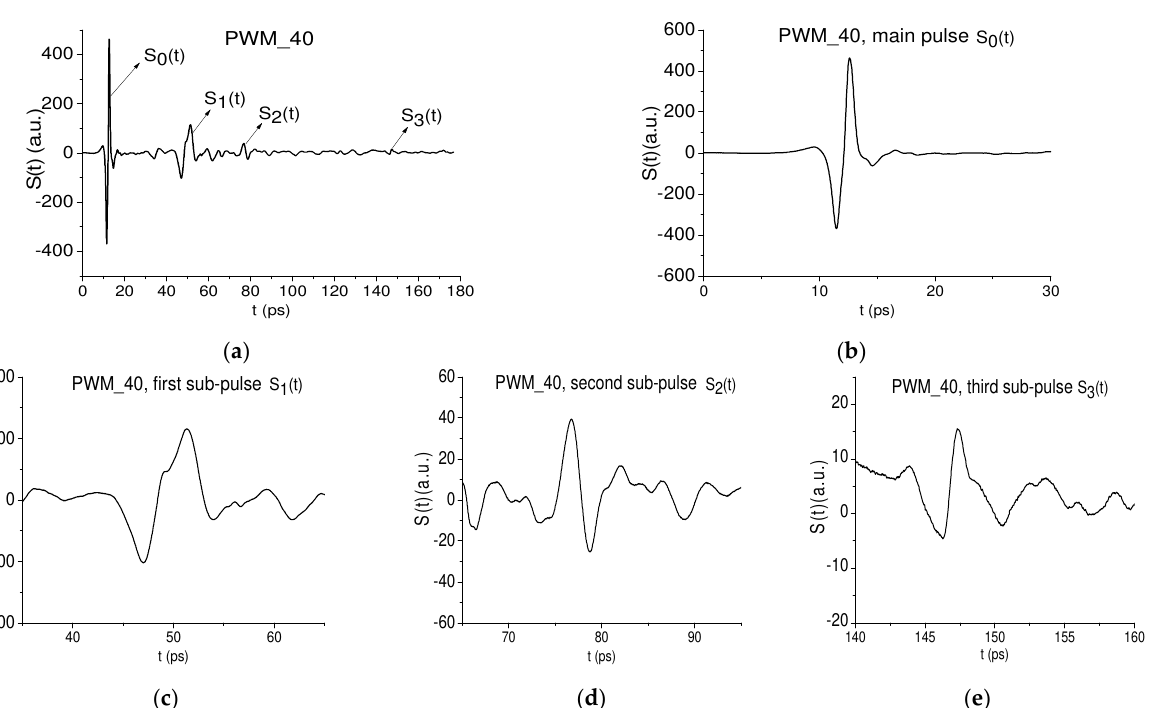
( ) S t Figure 9c and ( ) S t Figure 9e have the 1 3 ( ) S t Figure 9b. At the same time, the sub-pulse ( ) S t 0 2